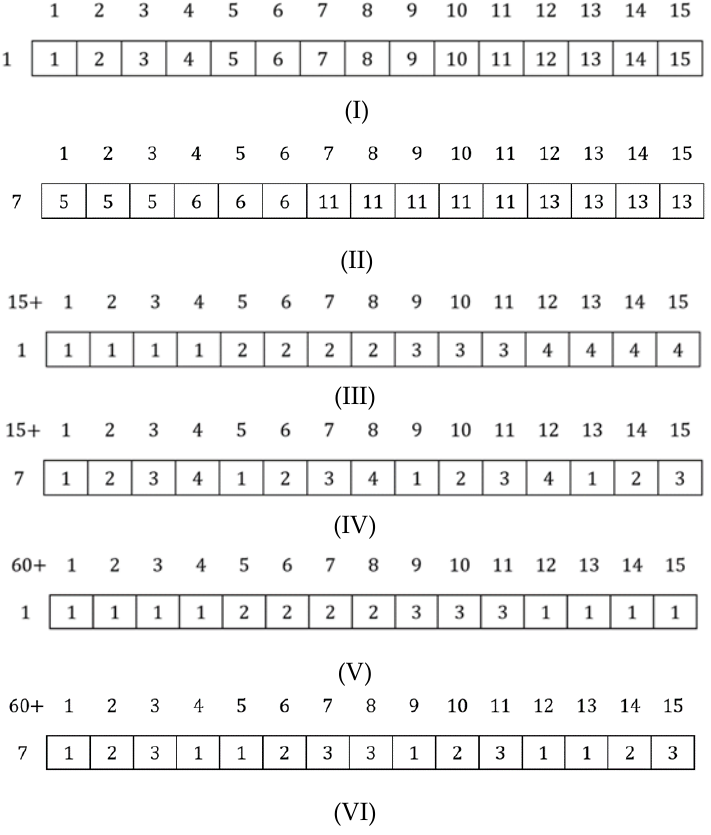
Figure 8. I,II indicate the site selection code, III, IV indicate the vehicle type selection code from the recycling center to the processing center, the vehicle selection code from the processing center to the recycling center and the vehicle type selection code from the processing center to the paper mill and landfill, V,VI are the processing technology selection